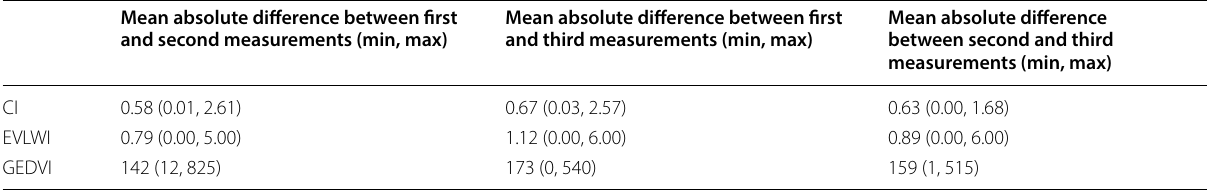
Table 2 Mean absolute differences between the first, second and third measurements for CI, EVLWI, GEDVI at HDP Mean absolute difference between first Mean absolute difference between first Mean absolute difference and second measurements (min, max) and third measurements (min, max) between second and